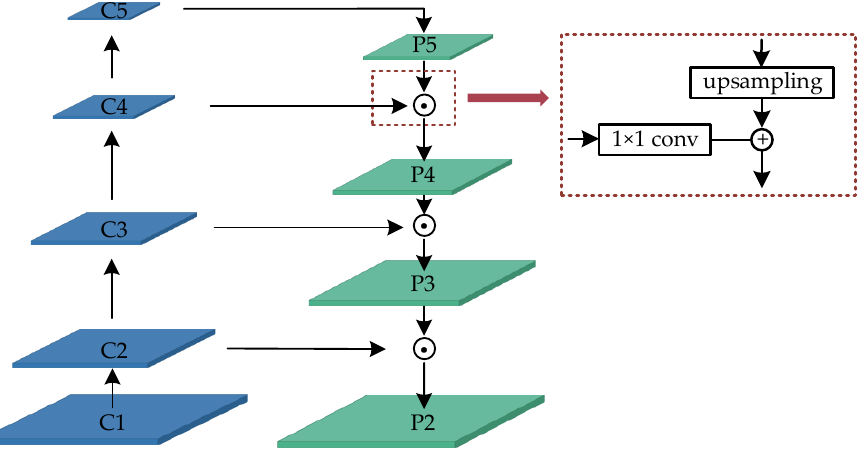
Figure 2. Structure of feature pyramid network (FPN).